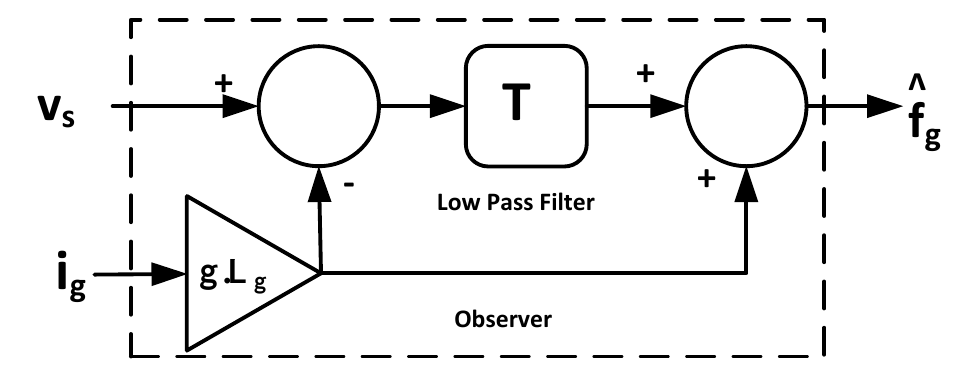
Figure 3. Disturbance observer (DOb) block diagram.